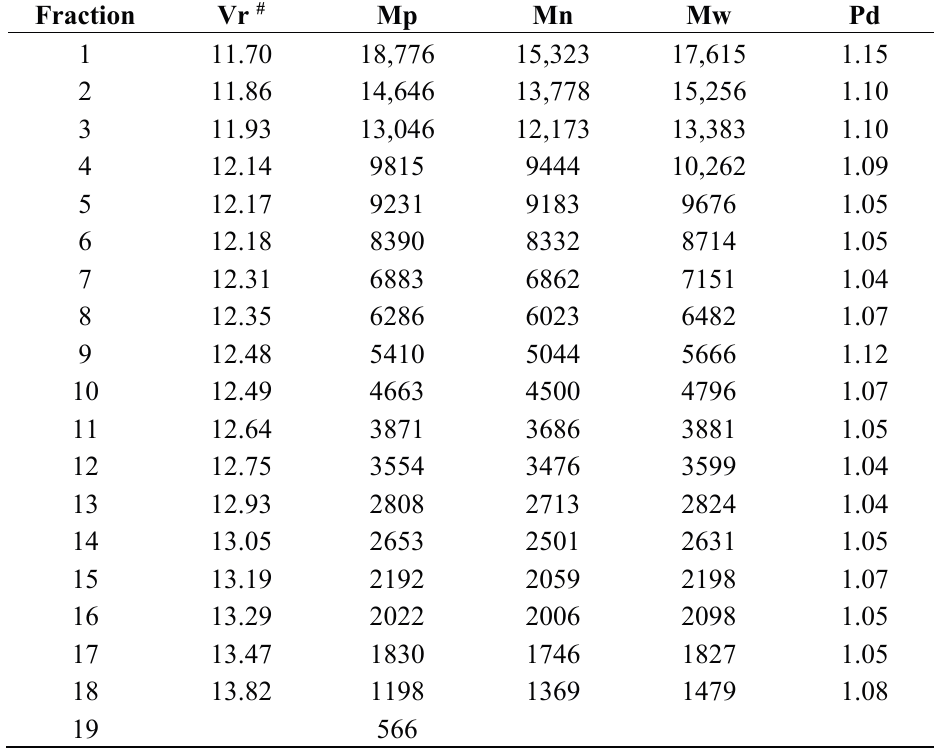
Table 2. In addition to selected fractions, a heparin disaccharide, 2-O-sulfated- α - L -iduronic acid 1 → 4 linked to 6-O-sulfated anhydromannitol residue (molecular mass 566 Da) was used for calibration purpose. Table 2. Characterization by HP-SEC/TDA method of eighteen selected narrow cut fractions obtained from γ -hep by size exclusion chromatography. Mp value of the heparin derived disaccharide is also